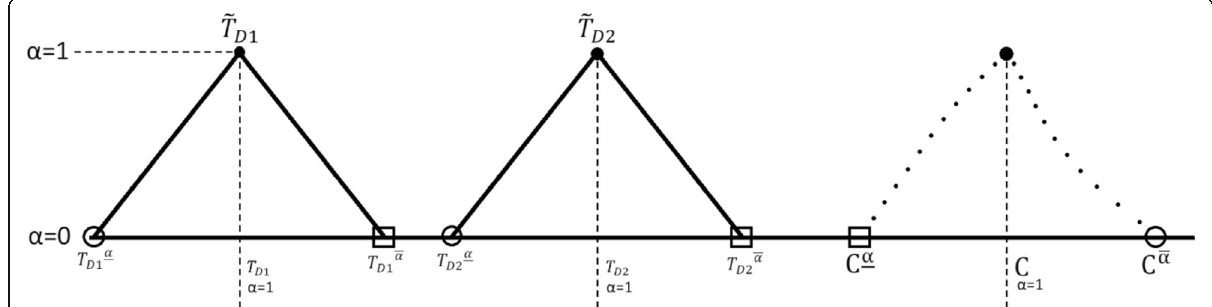
Fig. 5 Calculation of the core and the support of fuzzy maximum capacity obtained from triangular fuzzy Dwell Times, α -cuts